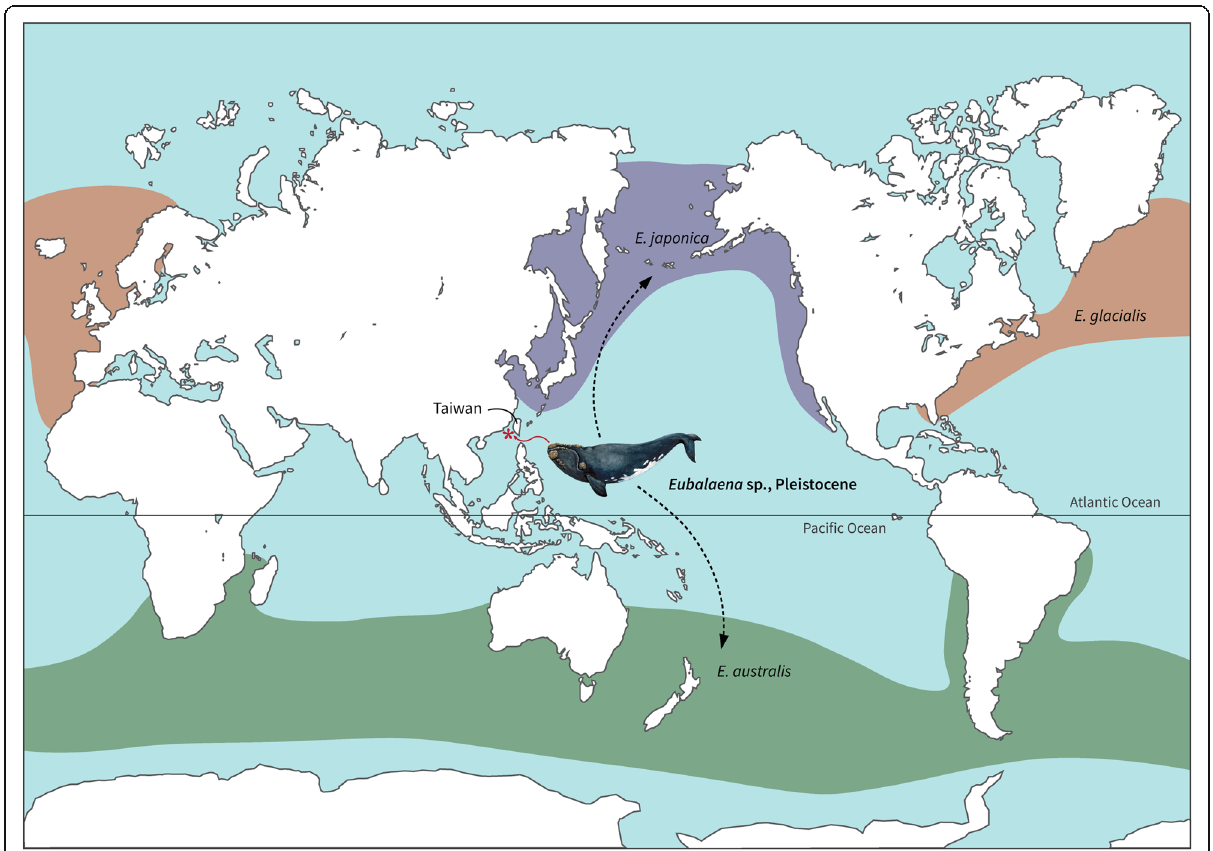
Fig. 1 The occurrence of a tropical Eubalaena from the Pleistocene of Taiwan (starred) and the proposed distribution of Eubalaena australis , E. glacialis , and E. japonica (tinted, modified from Wilson and Mittermeier [28]). The dash line indicates a possible western Pacific pathway for the Eubalaena